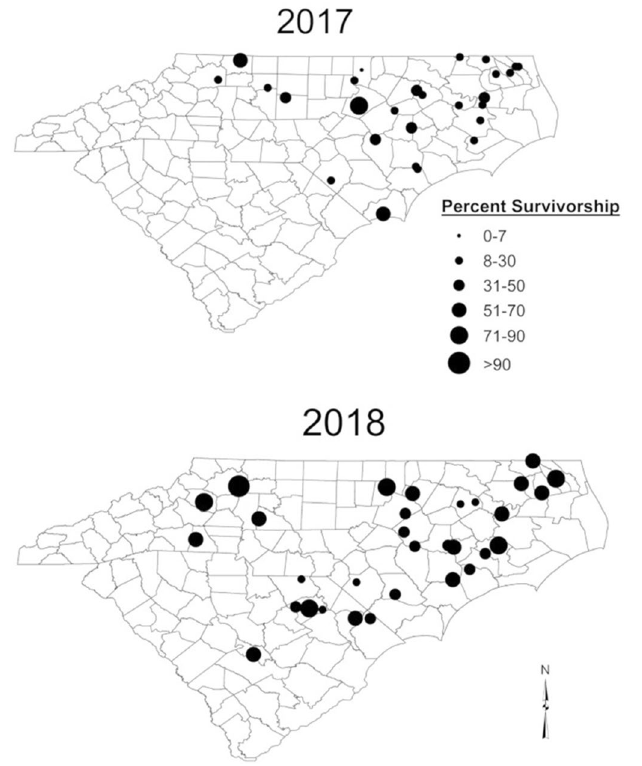
Figure 2. Survivorship of H. zea from different collection sites in 2017 (n = 28) and 2018 (n = 31) following exposure to 29 µg/cm 2 Cry1Ac in diet-overlay assay. Each dot represents the collection site and dot size represents percent